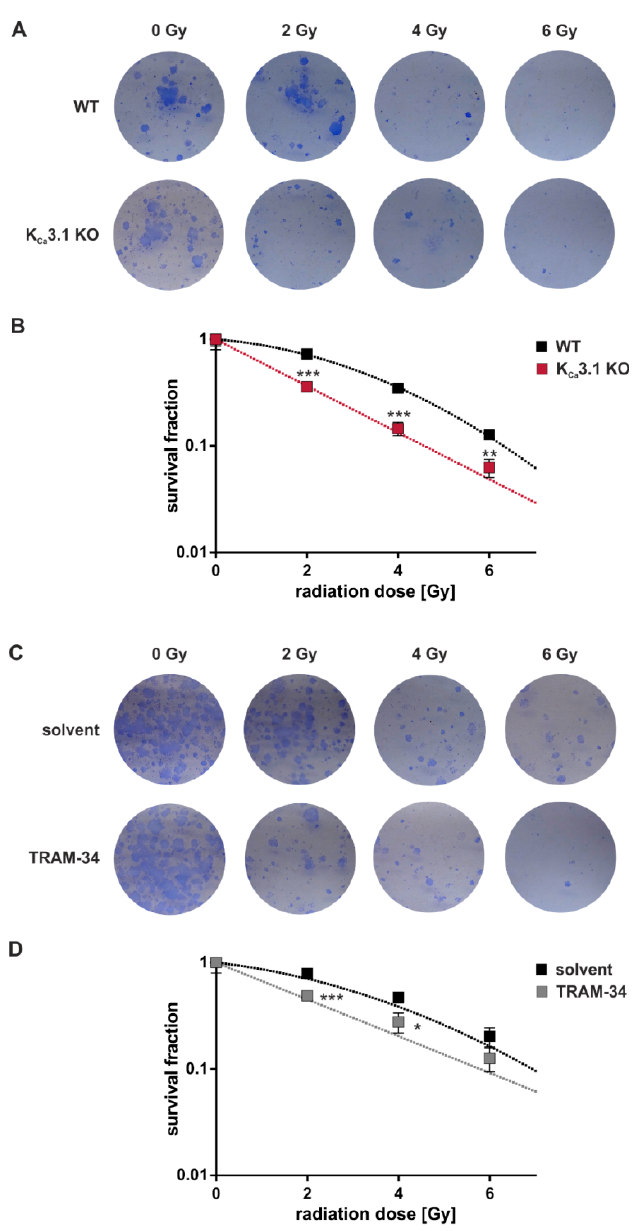
Figure 3. Clonogenic survival of irradiated MMTV-PyMT breast cancer cells in vitro depends on K Ca 3.1. ( A ) Light micrographs of colonies formed from MMTV-PyMT WT (upper row) and K Ca 3.1 KO (lower row) cells upon exposure to 0, 2, 4, or 6 Gy ionizing radiation. ( B ) Mean (± SE, n = 9 with 6 technical replicates per experiment) survival fractions of irradiated (0–6 Gy) K Ca 3.1 WT (black) and KO cells (red) MMTV-PyMT breast cancer cells as determined as in ( A ) by delayed plating colony formation assay with data given semi-logarithmically as survival fraction / radiation dose plot. Survival